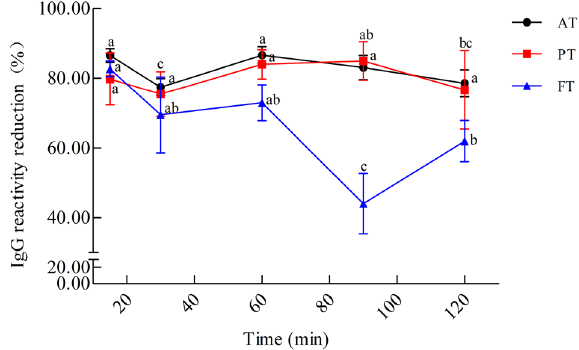
Figure 4. IgG reactivity of CM hydrolyzed with different enzymatic hydrolysis time. Alcalase-treated cow milk (AT), Protamex-treated cow milk (PT), Flavourzyme-treated cow milk (FT). Each value represents the mean of three independent experiments ± SD. Different letters indicate significant differences among groups ( P < 0.05).